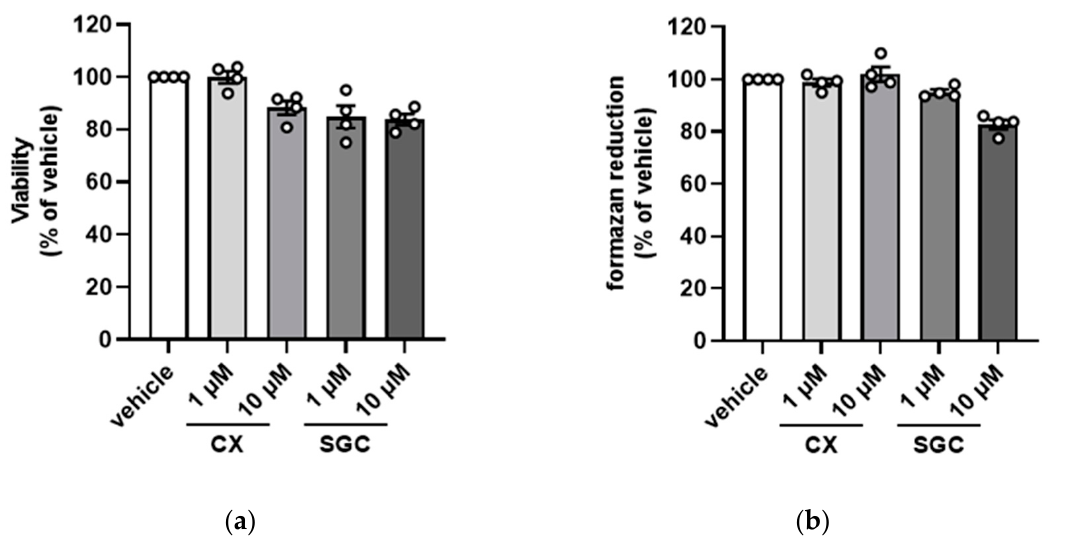
Figure 1. Impact of the treatment of MIN6 cells with SGC-CK2-1 or CX-4945 on cell viability. MIN6 cells were treated with 1 or 10 µM SGC-CK2-1 (SGC) or 1 or 10 µM CX-4945 (CX) for 24 h. ( a ) Viability of cells was determined by counting living cells after trypan blue exclusion. Living cells in the control culture (vehicle) were set 100% and living cells in the treated culture were calculated in reference to it. ( b ) After 24 h treatment, the metabolic activity of MIN6 cells was analyzed by a WST-1 viability assay. Experiments were undertaken at least in quadruplicate and statistical analysis was performed as described in “Material and Methods”.